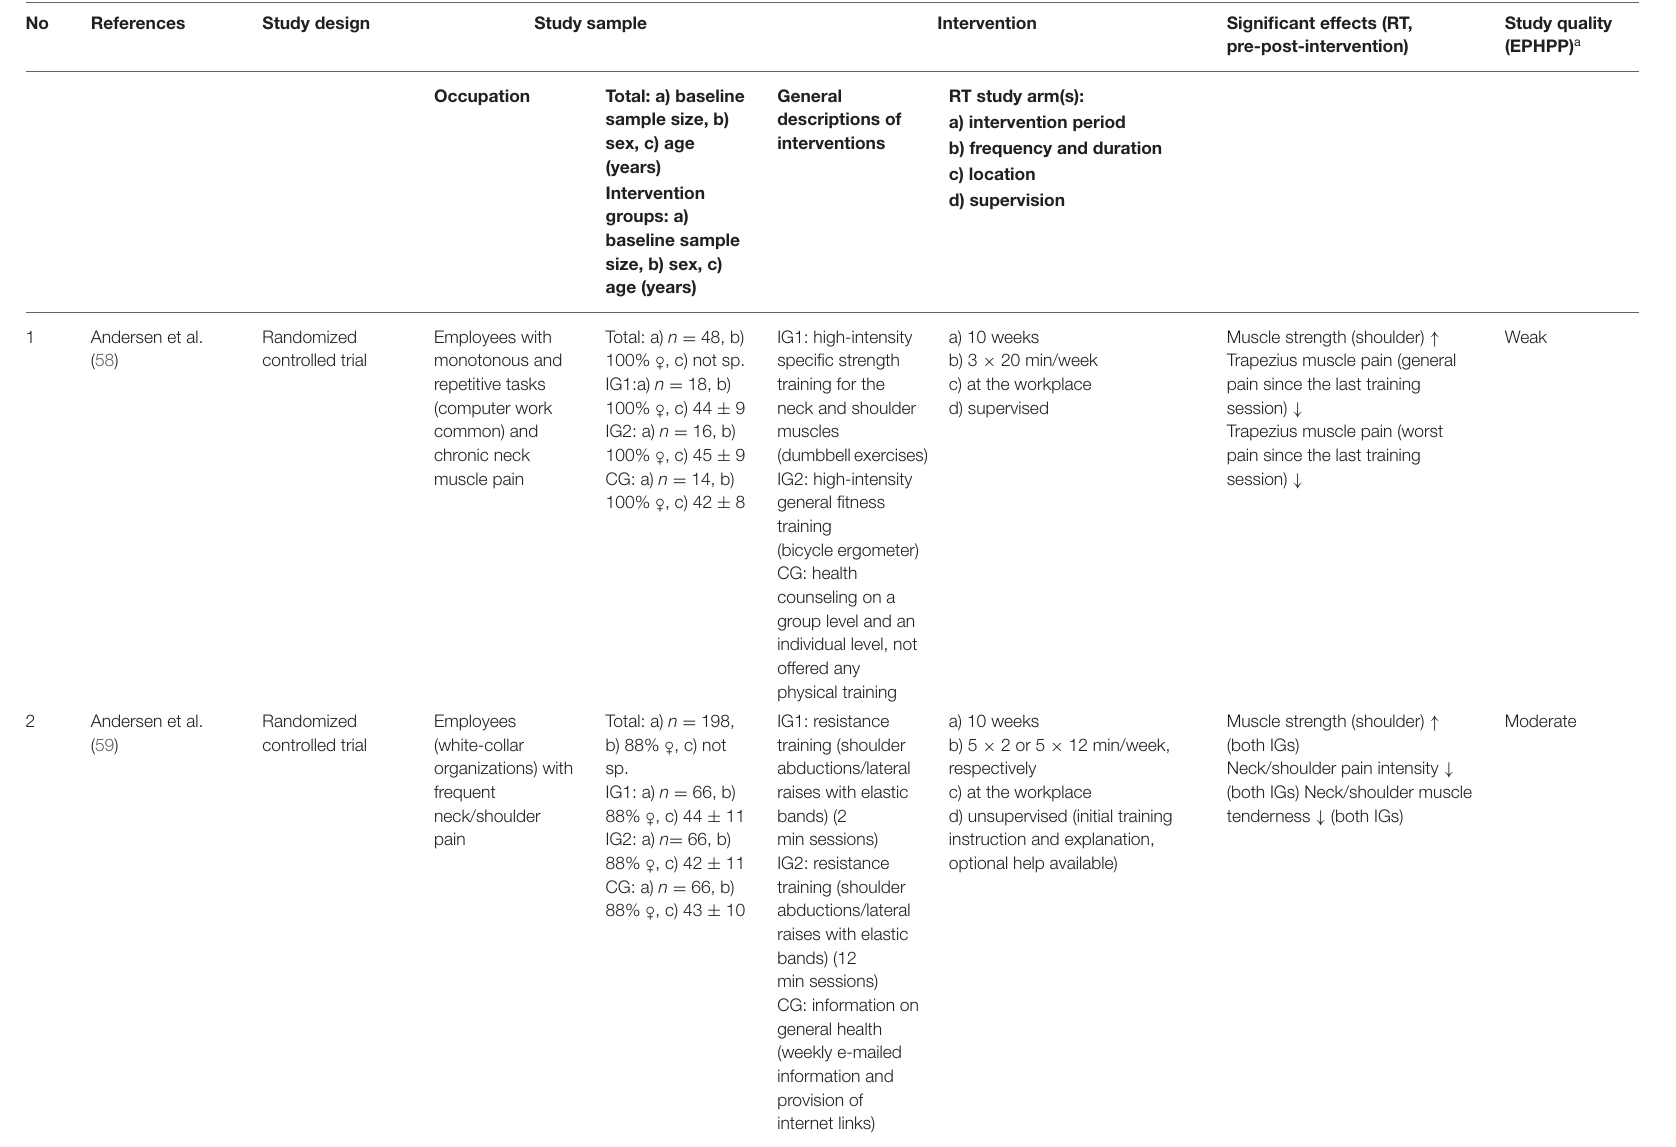
TABLE 3 | Included primary